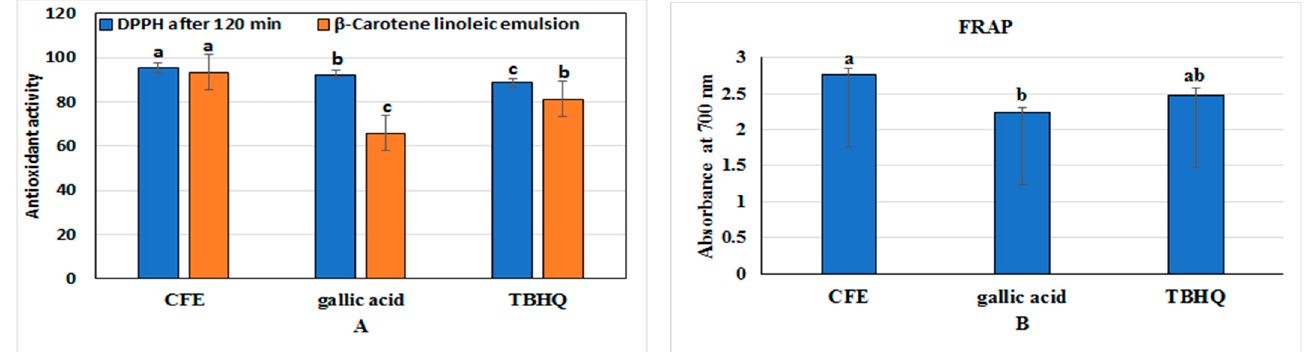
Figure 1. ( A ) Antioxidant activity of CFE against DPPH radical and β -Carotene/linoleic emulsion compared with gallic acid and TBHQ; ( B ) absorbance of ferric reducing power of CFE against gallic acid and TBHQ. Bars (represent treatment values) with different letters indicate significant difference between treatment values at p ≤ 0.05.